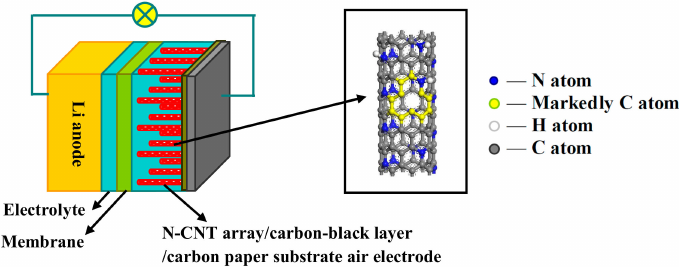
Figure 2. The schematic diagrams of a Li–air battery and molecular model of nitrogen-doped carbon nanotube (N-CNT) arrays containing N atoms replacing C